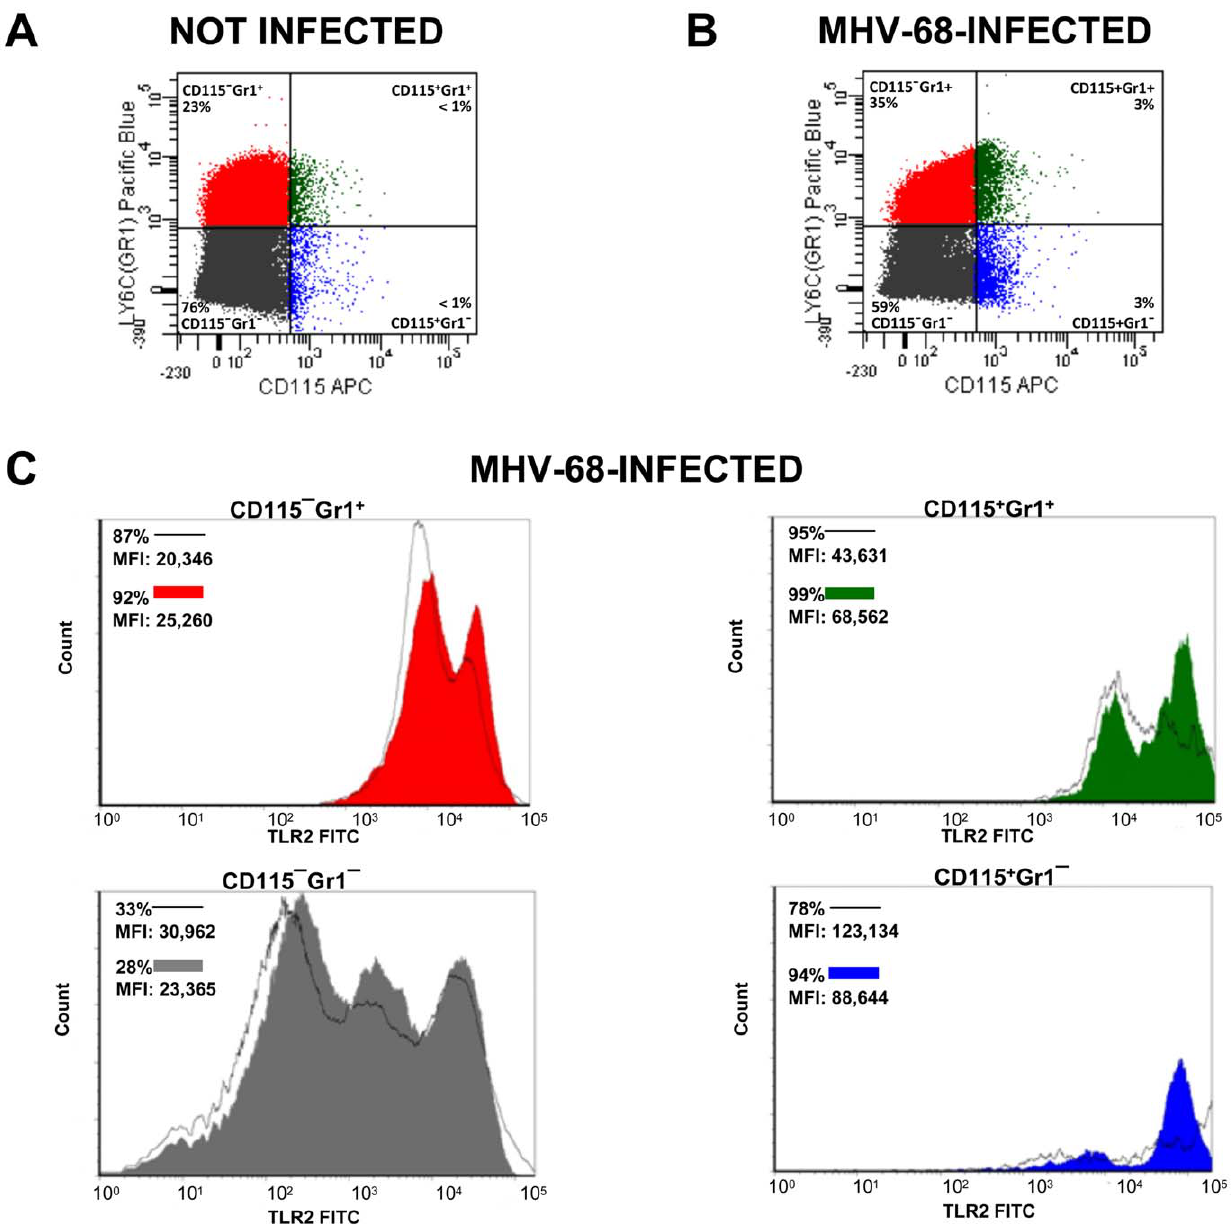
Figure 4. Expression of TLR2 in lungs of MHV-68-infected mice. ( A and B ) WT mice were left uninfected ( A ) or were infected in. with MHV-68 for 24 hours ( B ). Cells were isolated from lungs and stained with anti-CD115, anti-Gr1 and anti-TLR2 antibodies as detailed in the Materials and methods section. ( C ) The percentage of different cell subpopulations expressing TLR2 was determined by flow cytometry. Data are representative of two different experiments. MFI: Mean Fluorescence Intensity. Black lines: not infected. Coloured histograms: